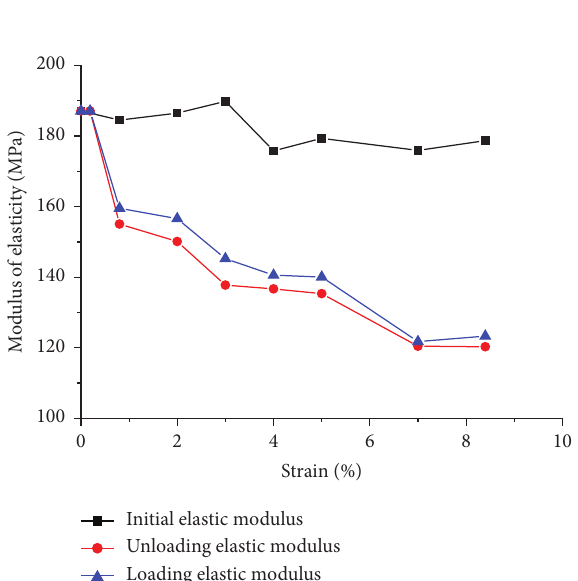
Figure 4: Comparison of elastic modulus during the three stages.